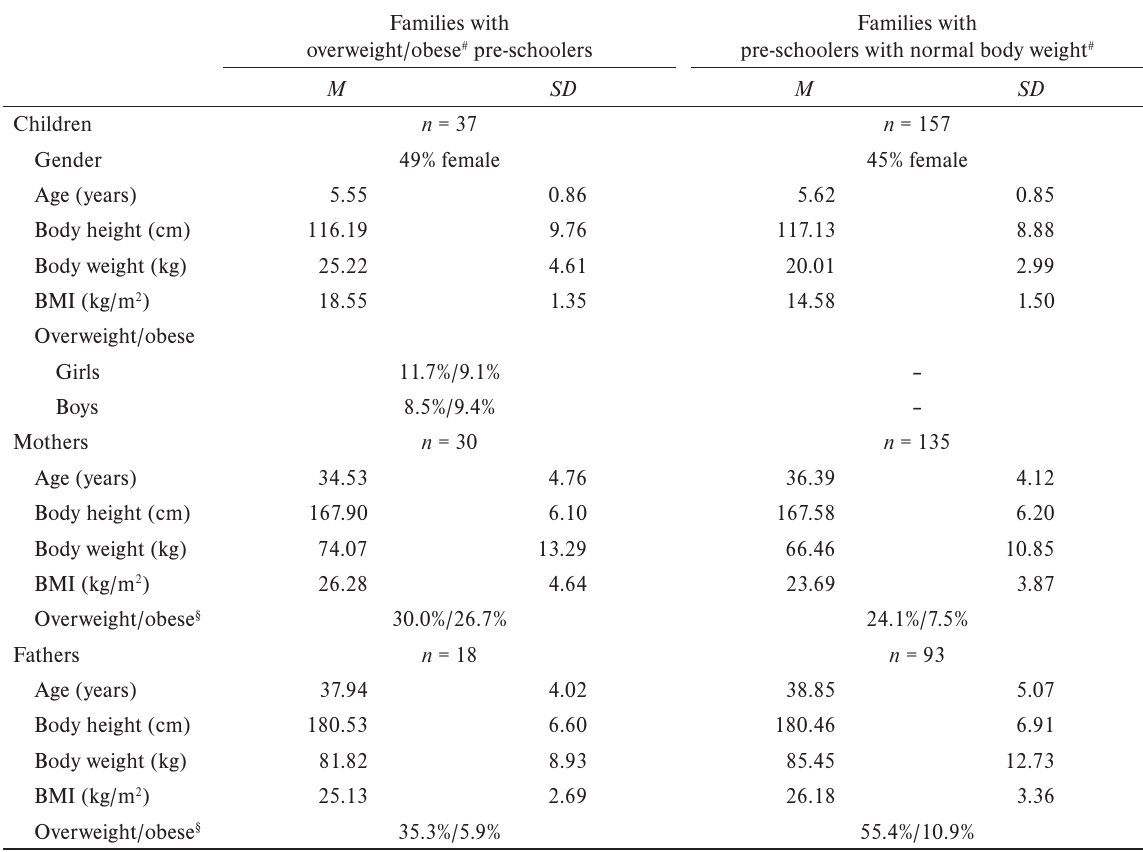
Overweight/obese